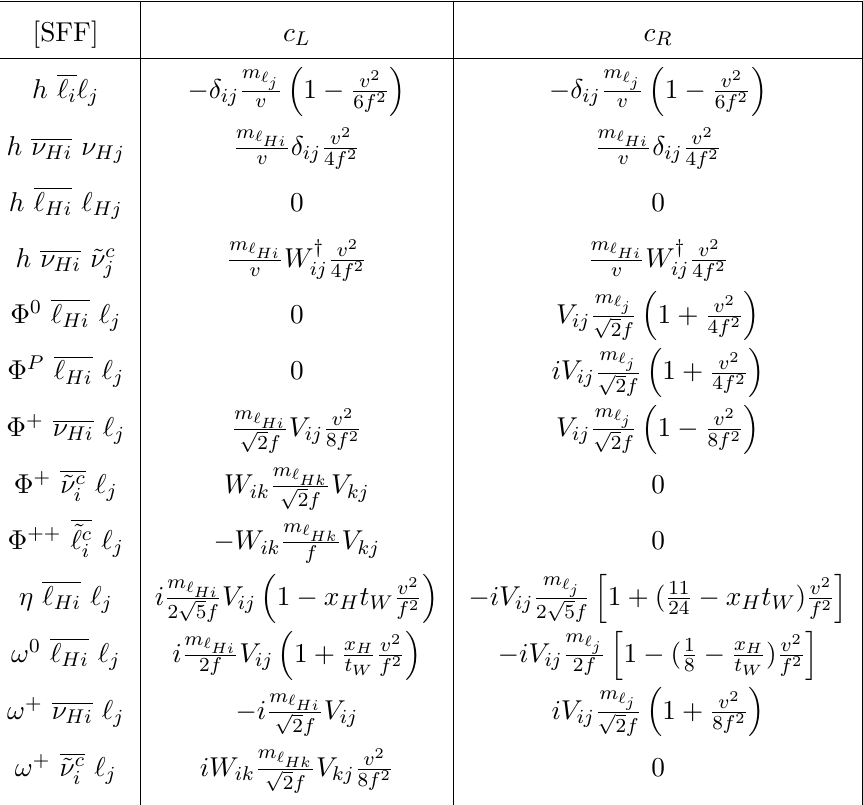
Table 2 . Scalar-Fermion-Fermion couplings at O ( v 2 =f 2 ). The corresponding couplings involving the (cid:9) Ri neutral singlet, (cid:31) Ri , vanish. We use t W = tan (cid:18) W = s W